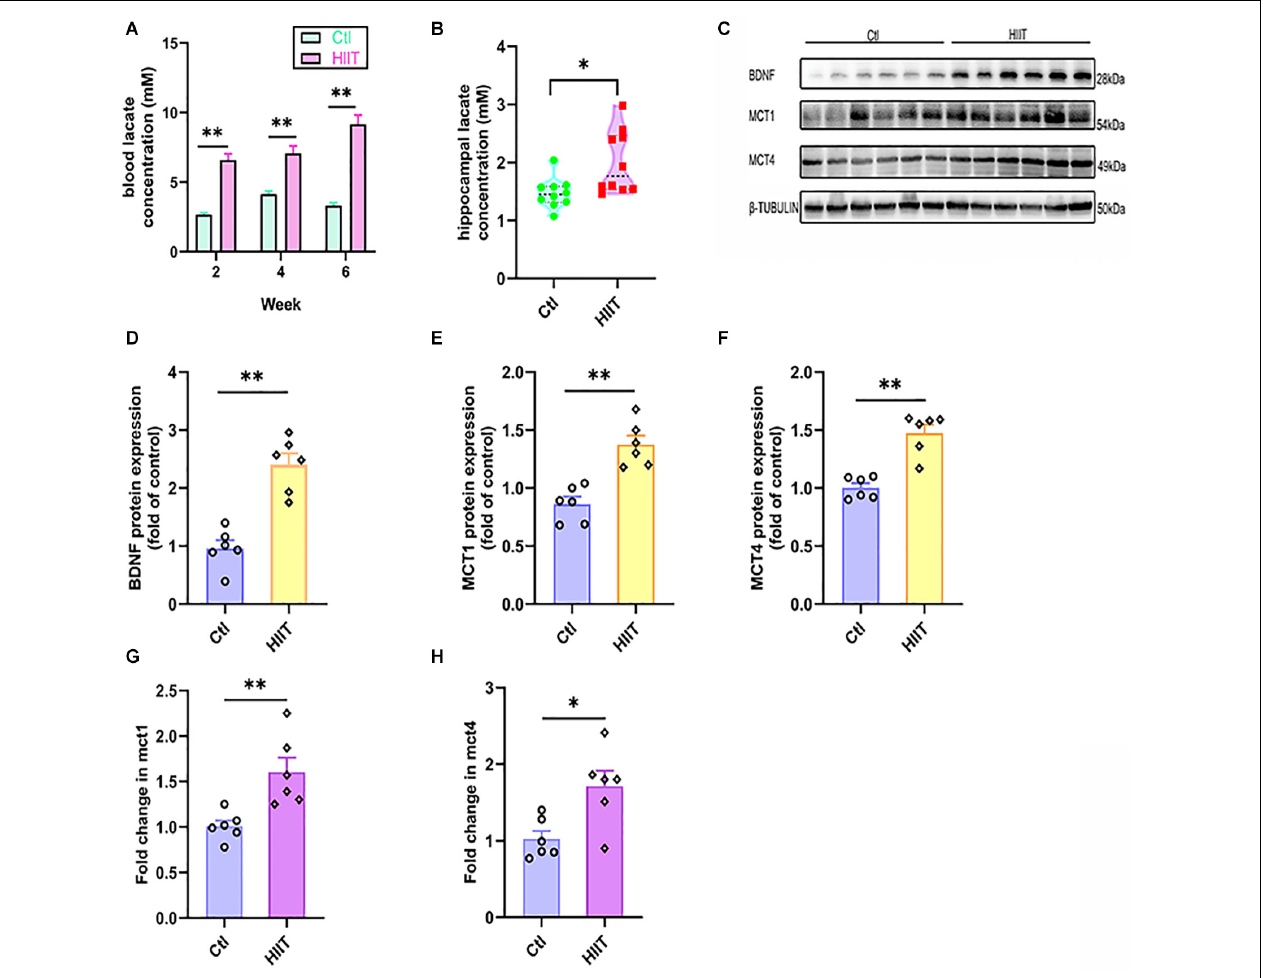
FIGURE 2 | HIIT increased lactate levels and promoted hippocampal MCT1/4 and BDNF expression. The blood lactate levels in two groups were detected at the end of 2nd, 4th, and 6th week of training to estimate the exercise intensity of High-intensity interval training (HIIT). The hippocampal lactate level was determined by colorimetry. The levels of Monocarboxylic acid transporter 1 (MCT1) and Monocarboxylic acid transporter 4 (MCT4) were also detected by RT-PCR and WB, respectively, to indirectly evaluate the lactate level in mouse hippocampus. The protein expression of Brain-derived neurotrophic factor (BDNF) was detected by